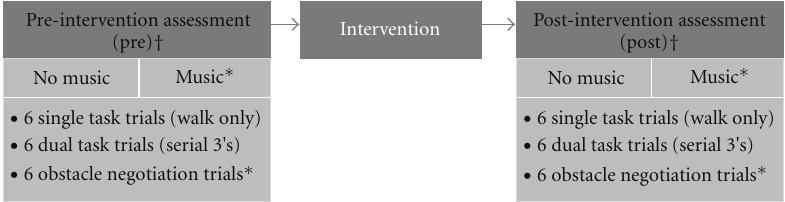
Figure 1: Experimental design. † Trials randomised. ∗ Not included in current